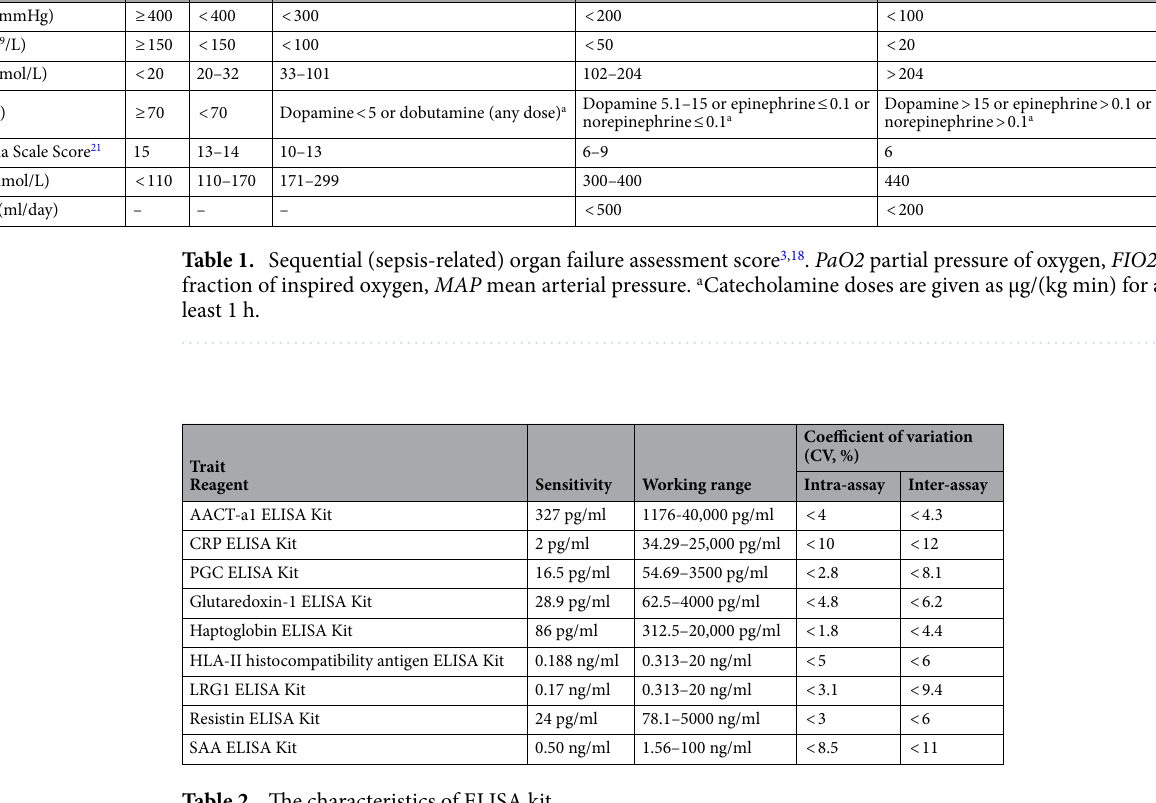
Table 2. The characteristics of ELISA